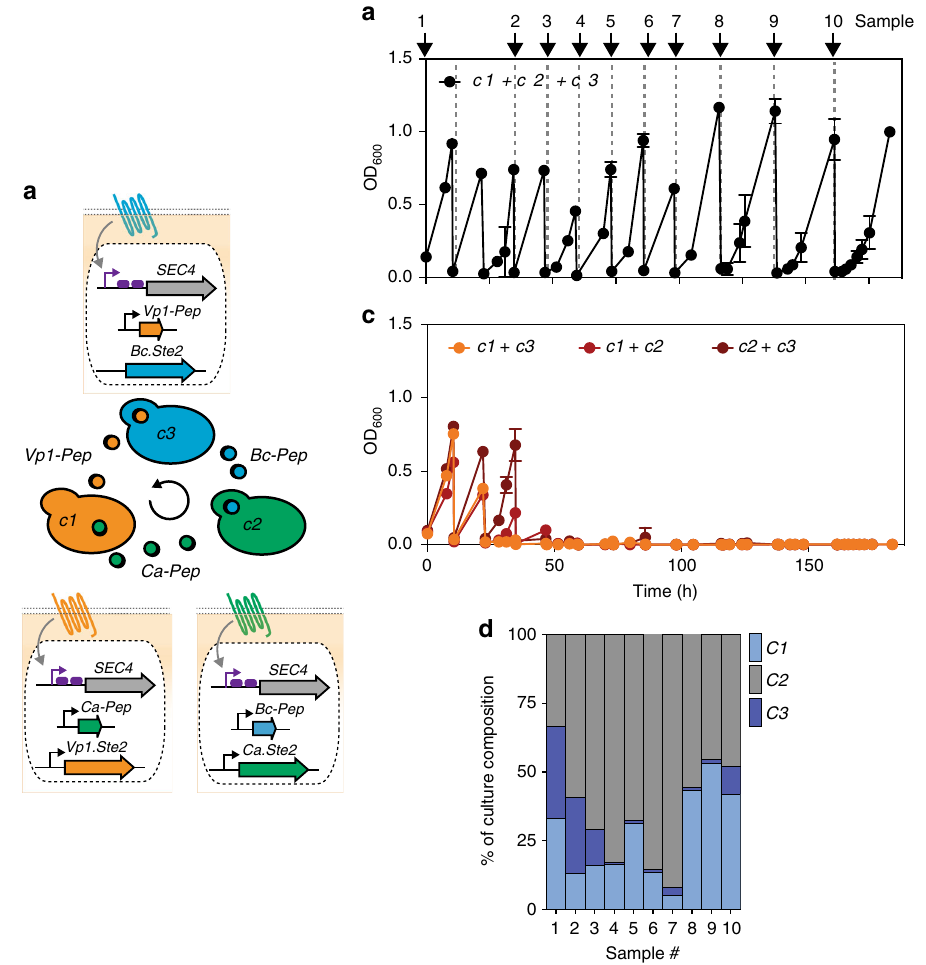
Fig. 4 The synthetic communication language enables construction of an interdependent microbial community. a Illustration of the interdependent microbial communities mediated by the peptide-based synthetic communication language. Peptide-signal interdependence was achieved by placing an essential gene ( SEC4 ) under GPCR control. In the featured three-yeast ring c1, c2 , and c3 secret the peptide needed for growth of the cx-1 member of the ring. Peptides are secreted from the constitutive ADH1 promoter. b , c Growth of the three-membered interdependent microbial community over > 7 days. Communities with one essential member dropped out collapse after ~ 2 days ( c ). Three-membered communities were seeded in a 1:1:1 ratio, controls were seeded using the same cell numbers for each member as for the three-membered community. All experiments were run in triplicate and error bars represent the standard deviation. d The composition of the culture was tracked over time by taking samples from one of the triplicates at the indicated time points, plating the cells on media selective for each of the three component strains, and colony